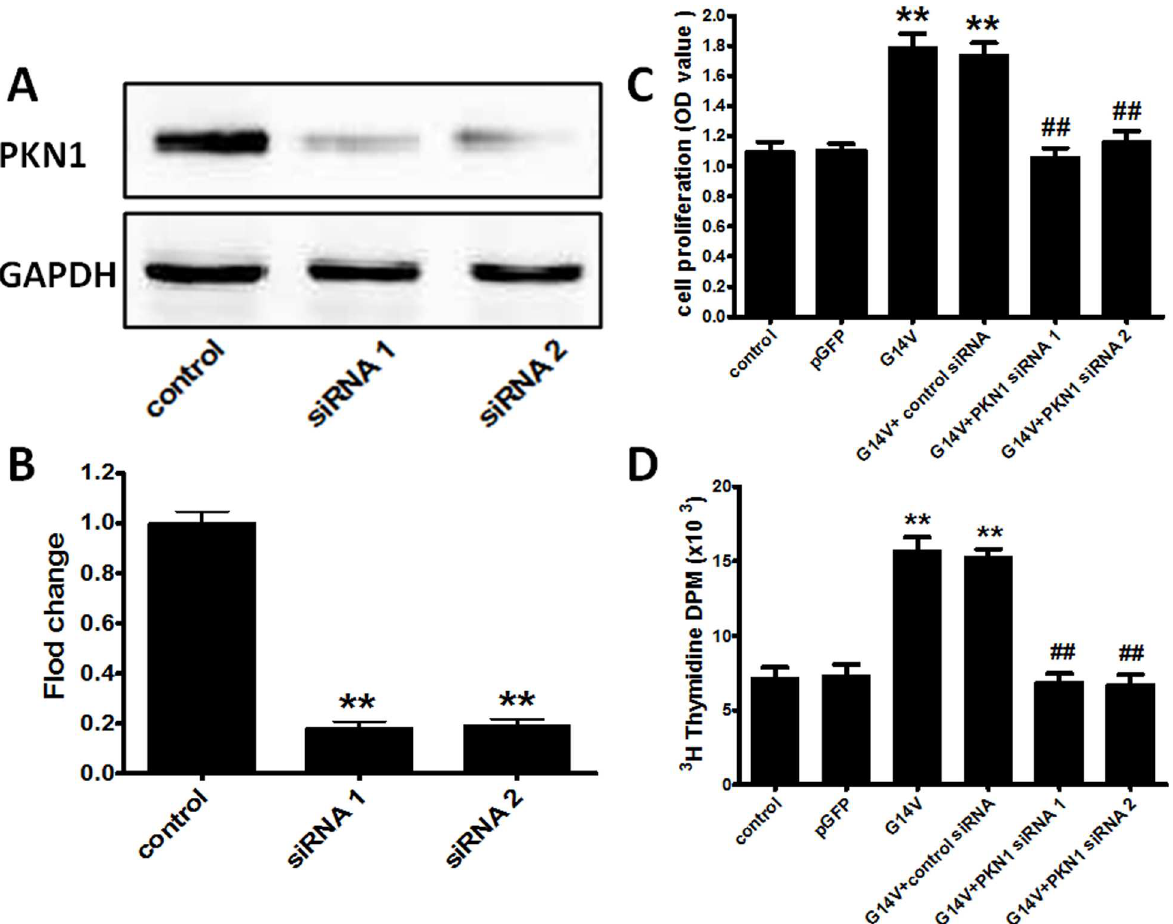
Fig 4. RhoA regulates huESC proliferation via PKN1 signaling: evidence from siRNA-mediated PKN1 knock-down assays. (A) A representative Western blot demonstrating the effects of two distinct PKN1 siRNAs. (B) Quantification of the Western blots in (A); ** P < 0.001versus control siRNA. After Lipofectamine-mediated transfectionof 1.5 μ g/ml G14V plasmid, 1.5 μ g/ml pGFP control plasmid, and 60 nM specific PKN1 siRNA into huESCs, a cell countingassay with CCK-8 (C) and a DNA synthesis assay with [ 3 H]- thymidineincorporation (D) were used to assess cell proliferation at a 48-h timepoint. The data are presentedas the mean ± SD of three independent experiments, each performed in duplicate(n = 3). The unpaired,two-tailedStudent’st-test was used to assess significance: ** P < 0.001versus control, ## P < 0.001versus G14V + control